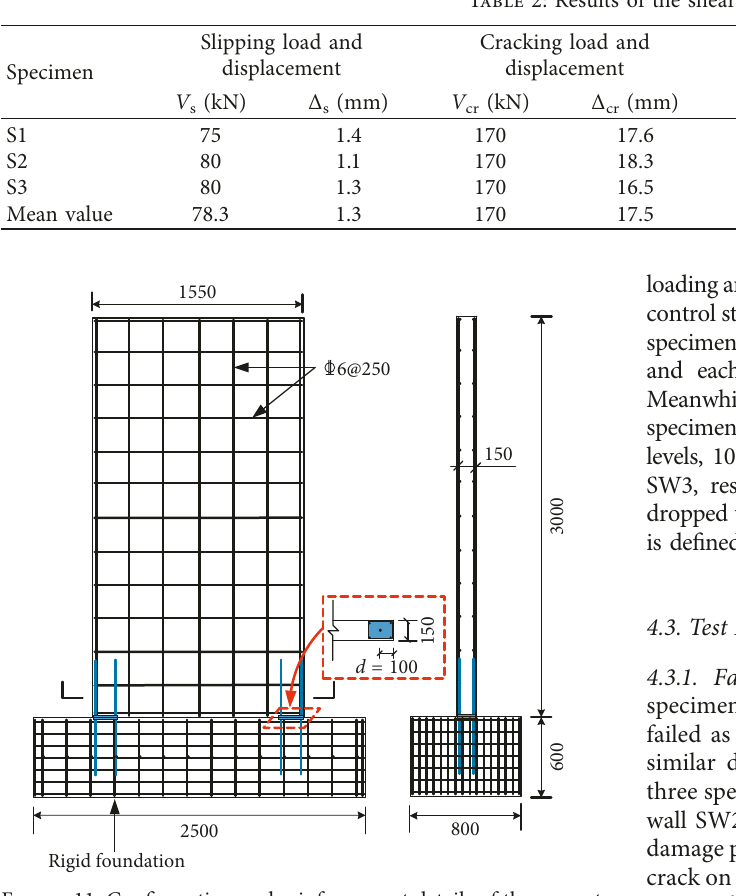
Figure 11: Configuration and reinforcement details of the precast shear walls (unit: